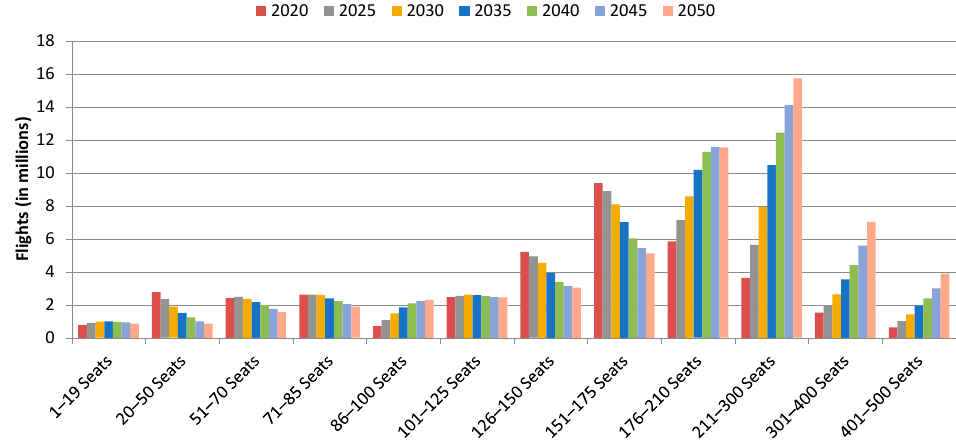
Figure 14. Fleet forecast results in the Low Scenario.